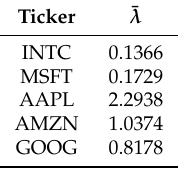
Table 2. Estimated parameters of 5 stocks via the law of large numbers (LLN) and functional central limit theorem (FCLT) assumptions.